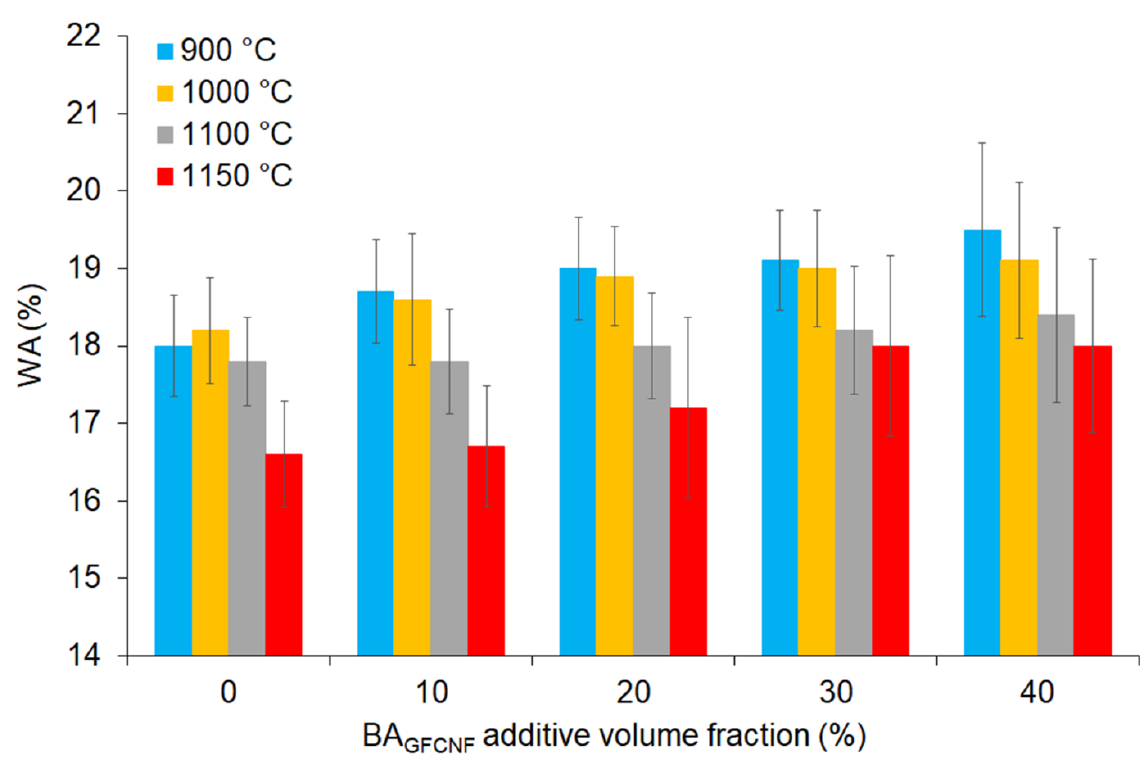
Figure 5. The values of WA depending on the BA GFCNF content, which ranged from 0 to 40%, and firing temperatures applied in the range of 900 to 1150 °C .